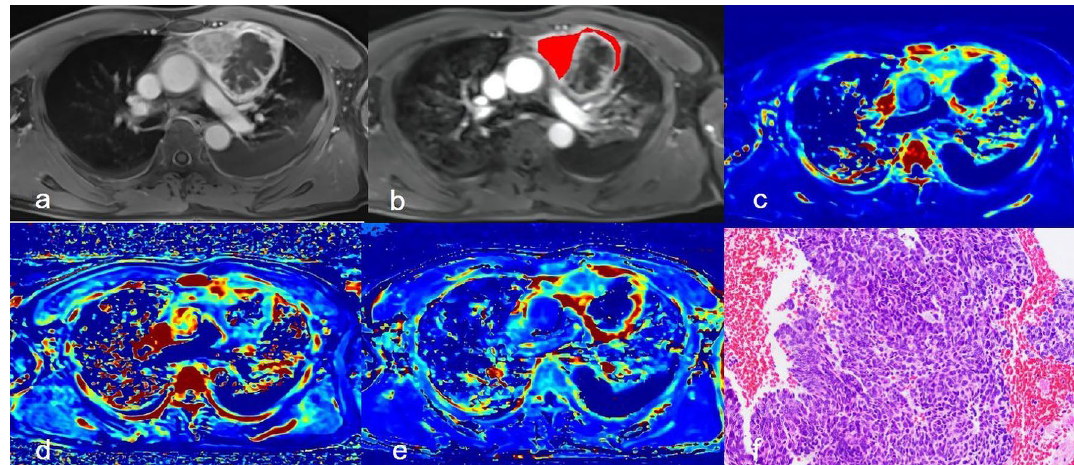
Figure 1. A 49-year-old man with thymic carcinoma ( a ) Dynamic contrast-enhanced scan showed anterior mediastinal mass, with cystic necrotic areas inside after enhancement; ( b ) Delineated the lesion; ( c - e ) Correspond to the generated Ktrans Map, Kep Map, and Ve Map; ( f ) Pathological sections (HE staining, 200 times magnification).